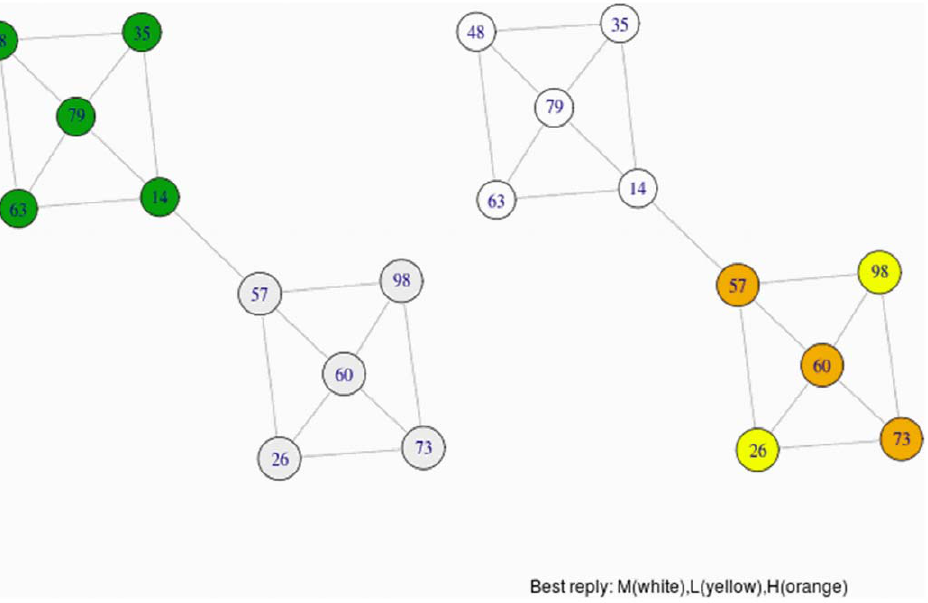
Figure 8. Partition in communities of the idealized case and final regimes. On the right, we can observe two different persistent regimes in the intratype game of white-tagged players depicted in Figure 7. The different regimes correspond exactly to the different communities showed on the left.